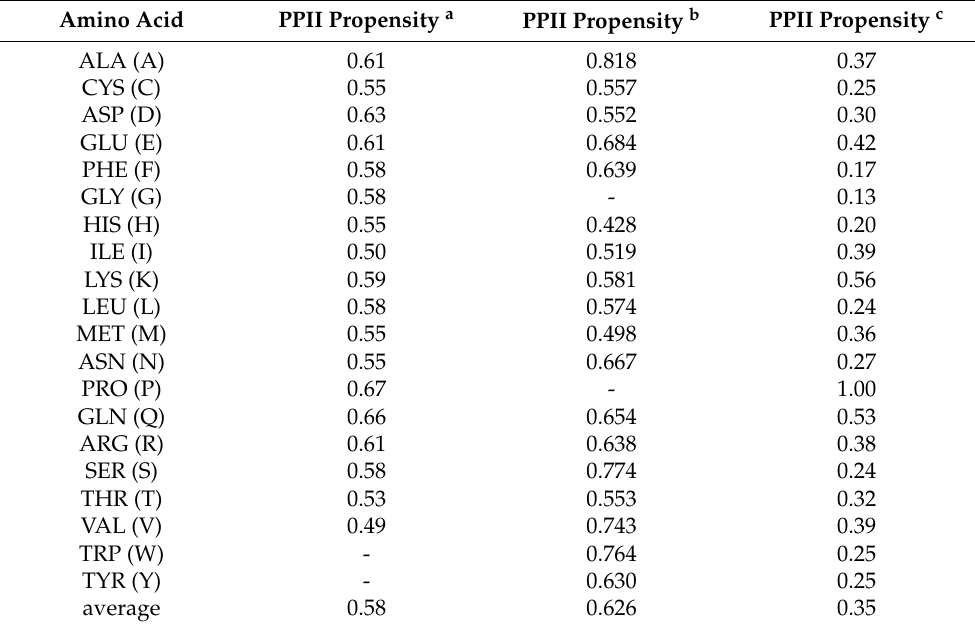
Table 1. Experimental intrinsic propensity for the PPII backbone conformation measured in short peptides. PPII Propensity a PPII Propensity